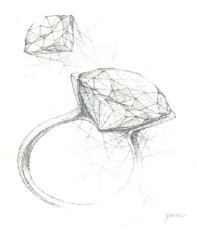
Figure 3. The elements of an engagement ring.